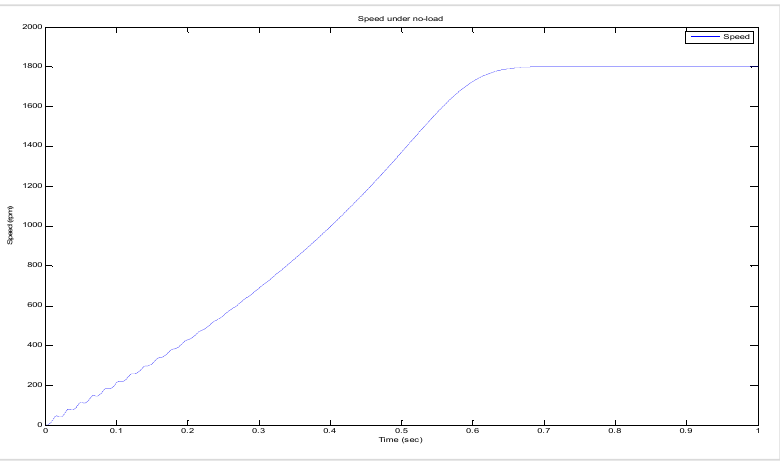
Figure 18. Speed under no load.